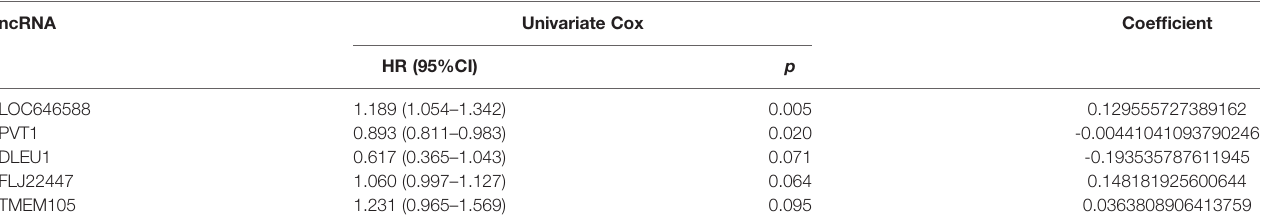
TABLE 2 | Results of univariate Cox analysis and LASSO analysis.